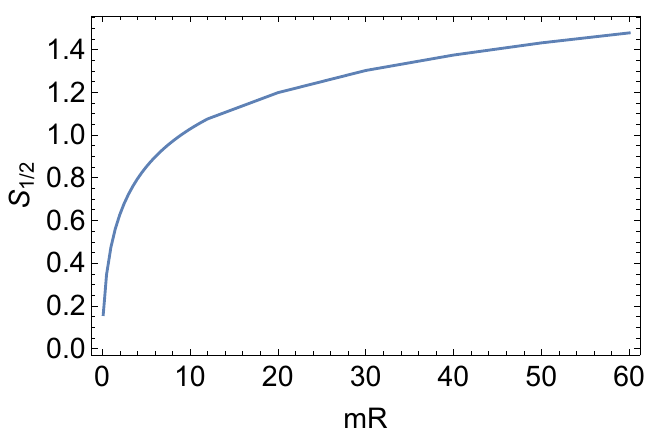
Figure 3 . Quantum (cid:12)delity for the RG (cid:13)ow in the Kondo model, formulated on the t = 0 line.